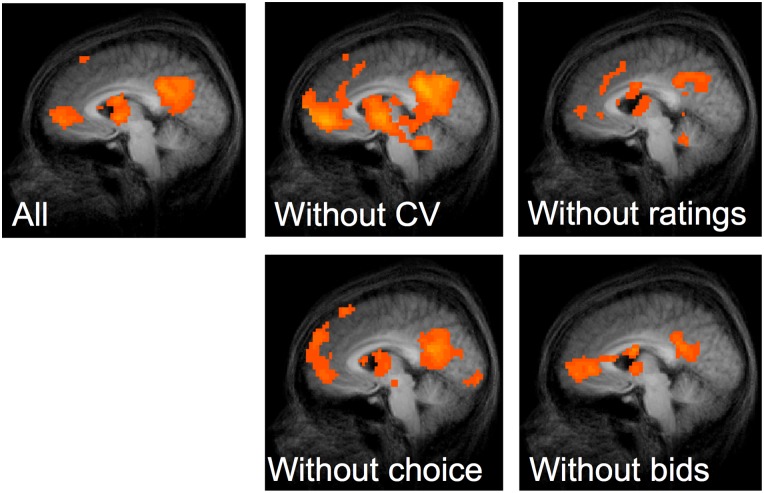
Statistical parameter maps for parametric regression including all behaviorally measured preferences as regressors and all possible “leave-one-out” combinations, replicating neural correlates identified in previous studies and meta-studies of subjective valuations.Clockwise from top left: Inclusive of all preferences, leaving out contingent valuations, leaving out activity ratings, leaving out snack food bids, and leaving out consumer good choices. Threshold for each map was set to p < 0.01, FDR corrected.